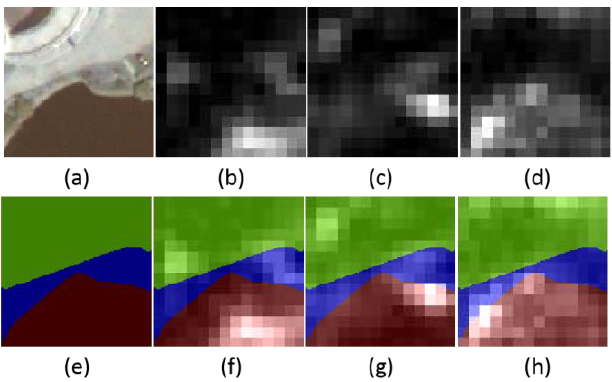
Figure 5. Attention weight matrix error. It shows mismatches between nouns in the caption and objects in the image. ( a ) is the input image; ( b – d ) are the attention maps for generating “green_space,” “service,” and “waterbody,” respectively; ( e ) is a small-scale segmentation map of ( a ); ( f – h ) are overlaid maps of ( b – d ), respectively, with ( e ). As shown in the figure, the attention area of the first generated noun “green_space” corresponds to the object “waterbody” in the image, which resulted in mismatch. Of the three nouns contained in the generated image caption, only the third noun matched the right object.